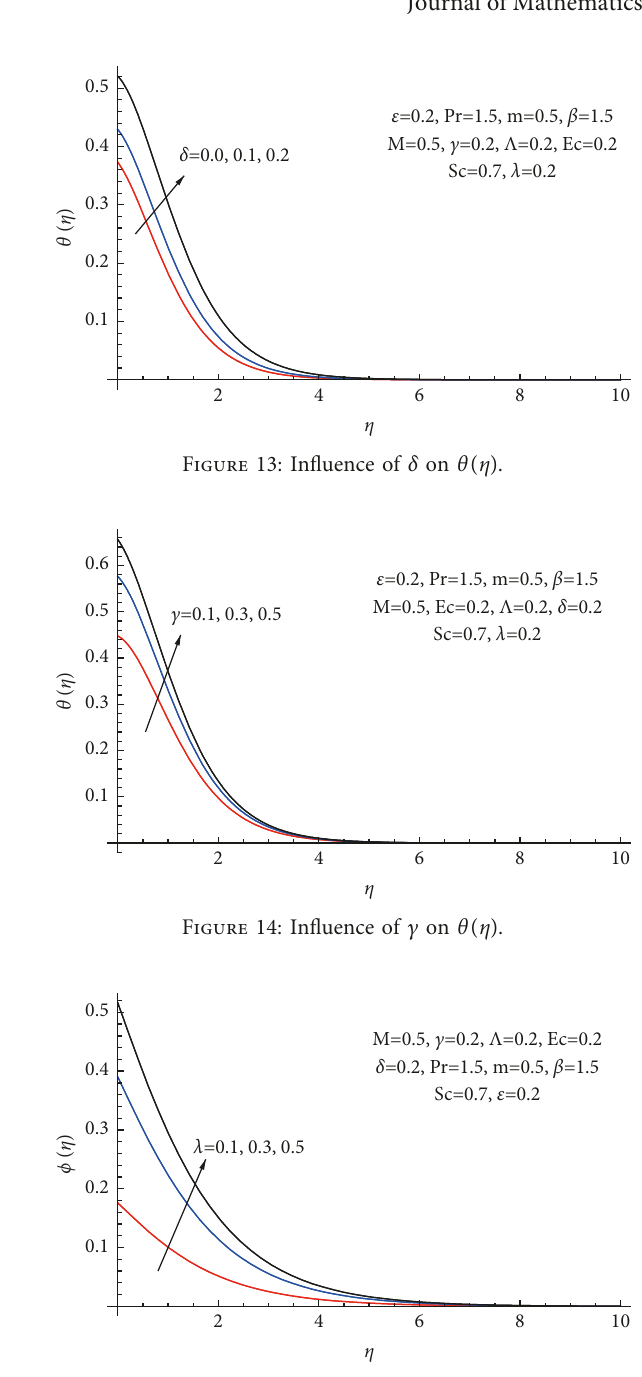
Figure 15: Influence of λ on ϕ ( η )